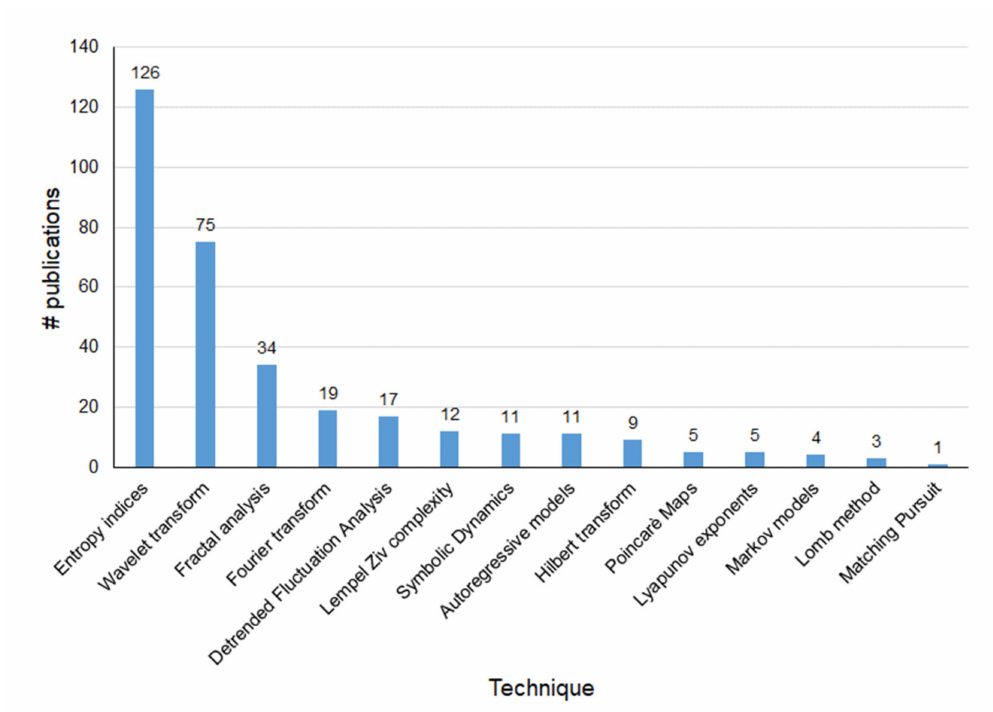
Figure 2. Number of publications identified through the Web of Science database grouped on the basis of the technique used for FHR processing and analysis (for better readability, only the time interval from 2000 to 2020 is shown).